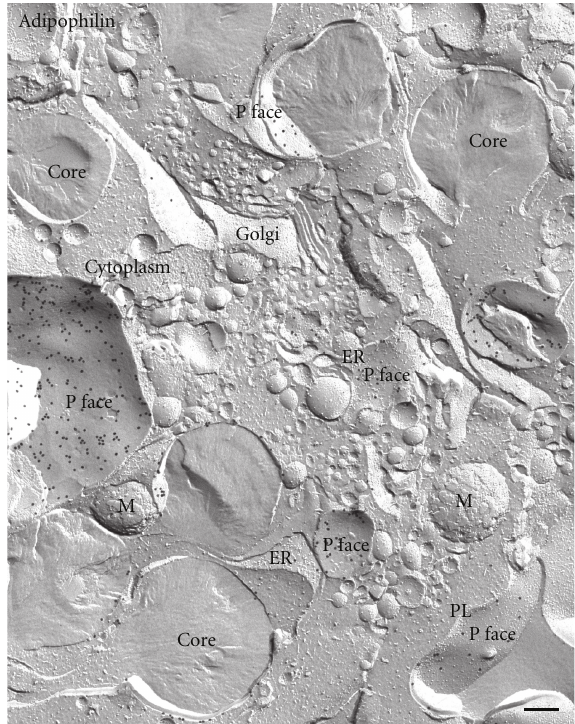
Figure 7: Freeze-fracture overview of organelles in a lipid-laden macrophage after labeling for adipophilin. Gold particles marking the presence of adipophilin can be seen in abundance in the outer phospholipid monolayer (P face) of lipid droplets, ER membrane and plasma membrane (PL). The Golgi apparatus (Golgi) is devoid of label. M mitochondria. Bar: 0.2 μ m.